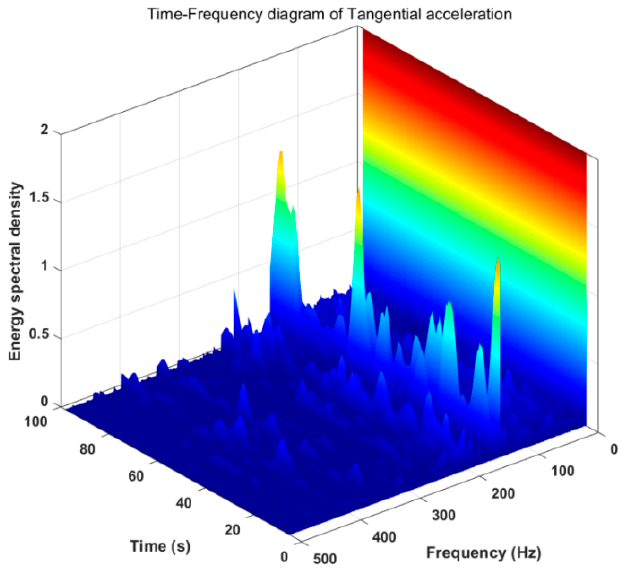
Figure 18. Time-frequency diagram of tangential acceleration of whirl. Figure 18. Time ‐ frequency diagram of tangential acceleration of whirl. Figure 18. Time ‐ frequency diagram of tangential acceleration of whirl.